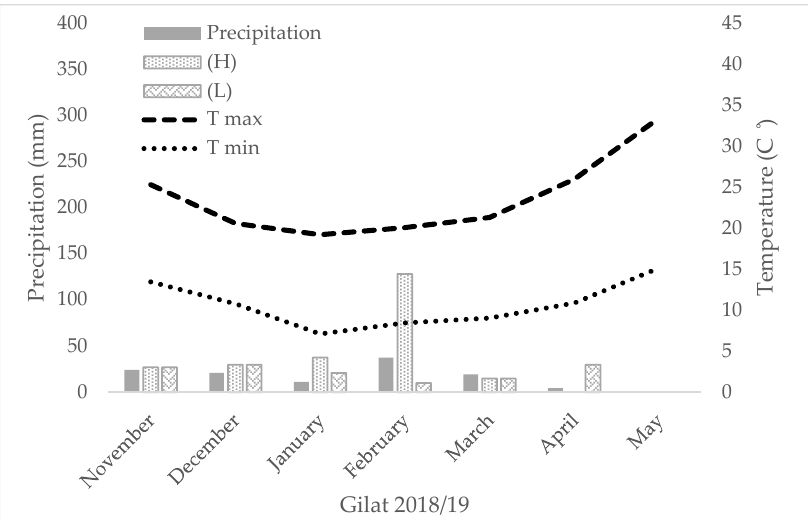
Figure A1. Seasonal temperature, precipitation, and supplementary irrigation of the five studied environments.